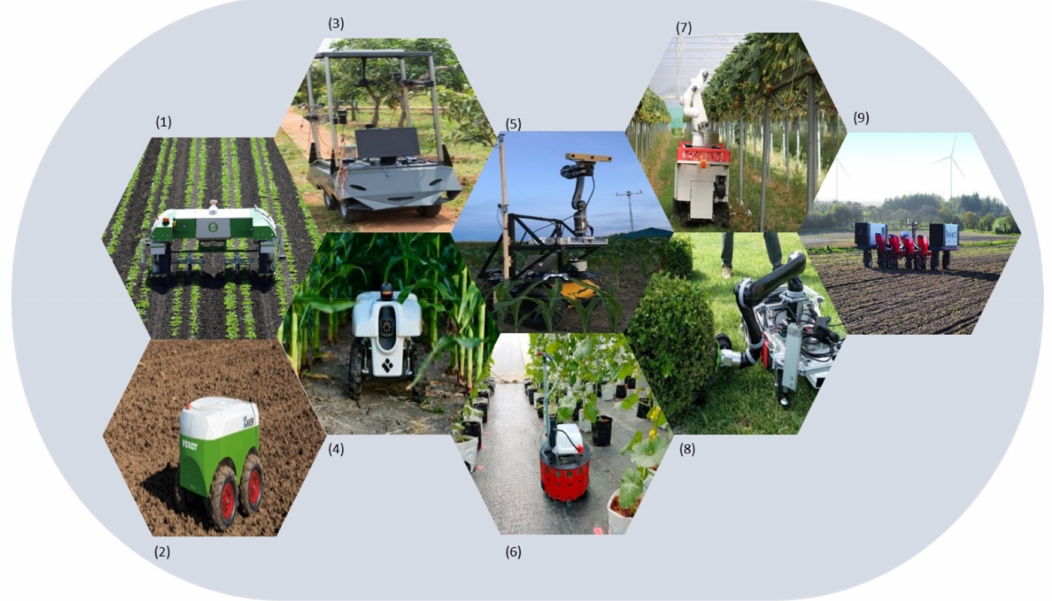
Figure 3. Representation of various types of agricultural robots (( 1 ) weeding [23], ( 2 ) seeding [47], ( 3 ) disease and insect detection [55], ( 4 ) plant monitoring [69], ( 5 ) phenotyping [78], ( 6 ) spraying [86], ( 7 ) harvesting [100], ( 8 ) plant management [152], ( 9 ) multi-purpose